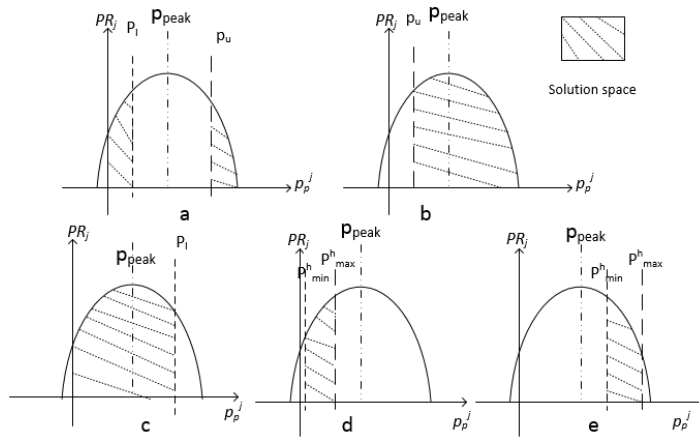
Figure 6. The solution space of three scenarios for problem in Equation (13). ( a ) Scenario 3; ( b ) Scenario 1(1); ( c ) Scenario 1(2); ( d ) Scenario 2(1); ( e ) Scenario 2(2).